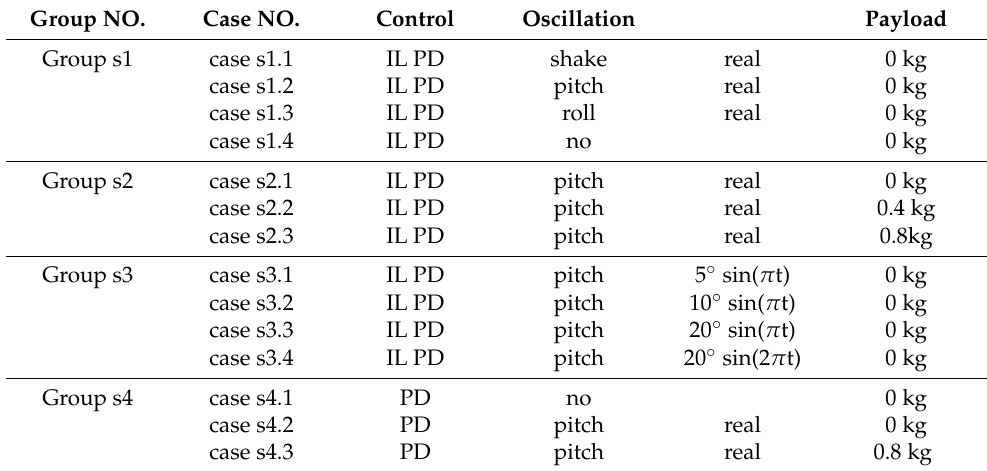
Table 1. Simulation groups. Group NO.